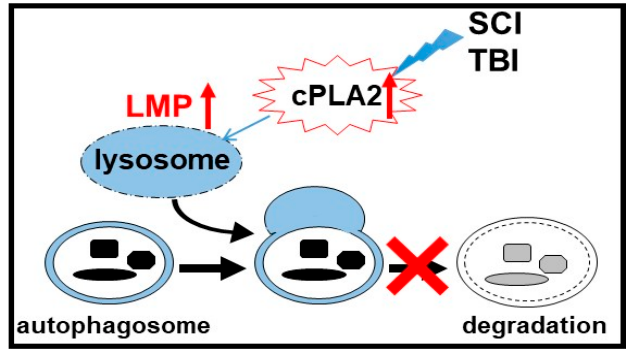
Figure 1. Spinal cord injury (SCI) and traumatic brain injury (TBI) activate cytosolic phospholipase A2 (cPLA2), mediating increased lysosomal membrane permeability (LMP), and leading to lysosomal damage and the inhibition of autophagy after SCI and TBI.